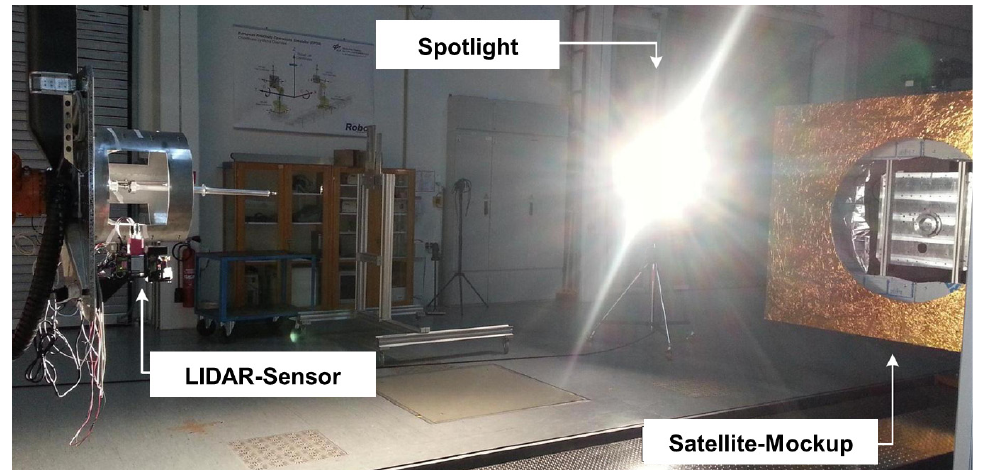
Figure 8. Setup for LiDAR tests. Note that the contact probe for fully six DoF contact dynamics simulation is also mounted, because the tests were performed at about the same